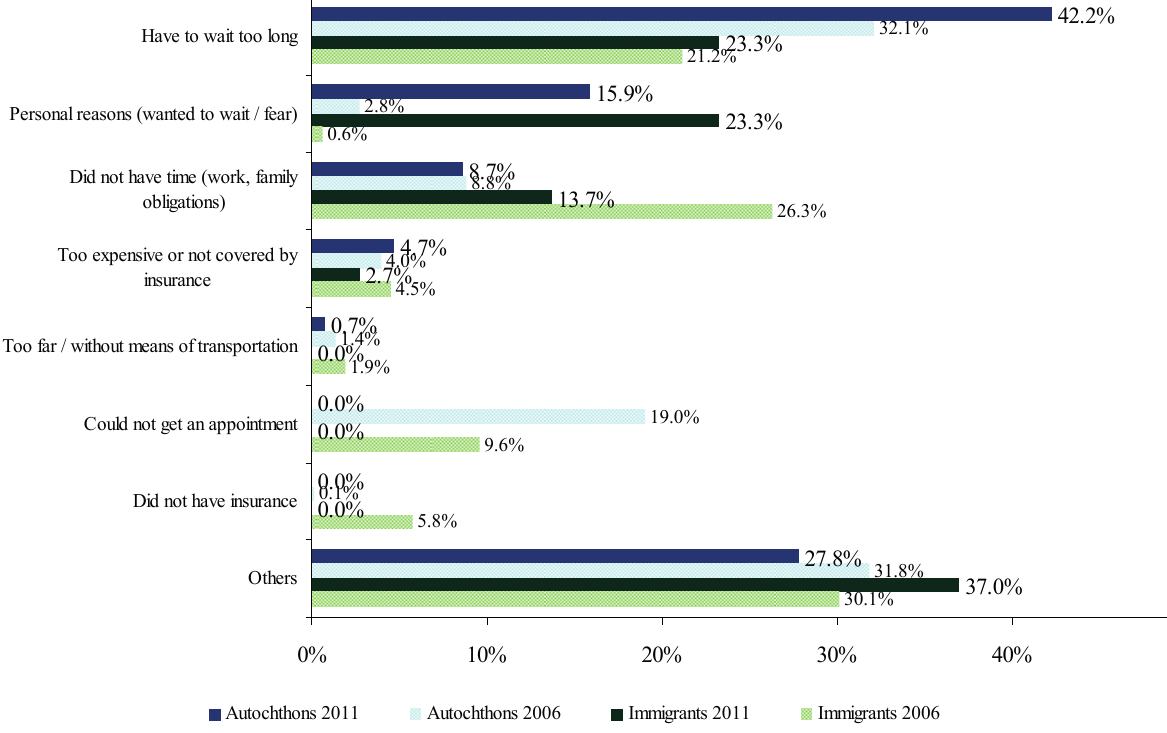
Figure 1. Reasons for not receiving health care services. SNHS 2006/07 and